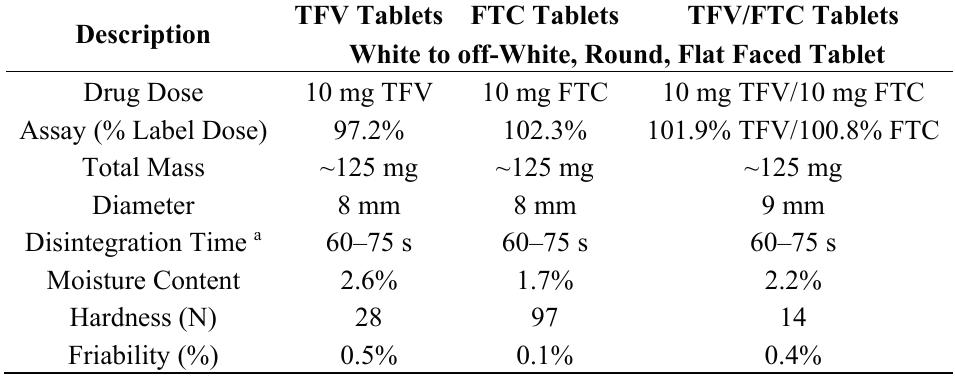
Table 1. Physicochemical properties of tenofovir (TFV), emtricitabine (FTC) and TFV/FTC tablets used in EpiVaginal and rabbit